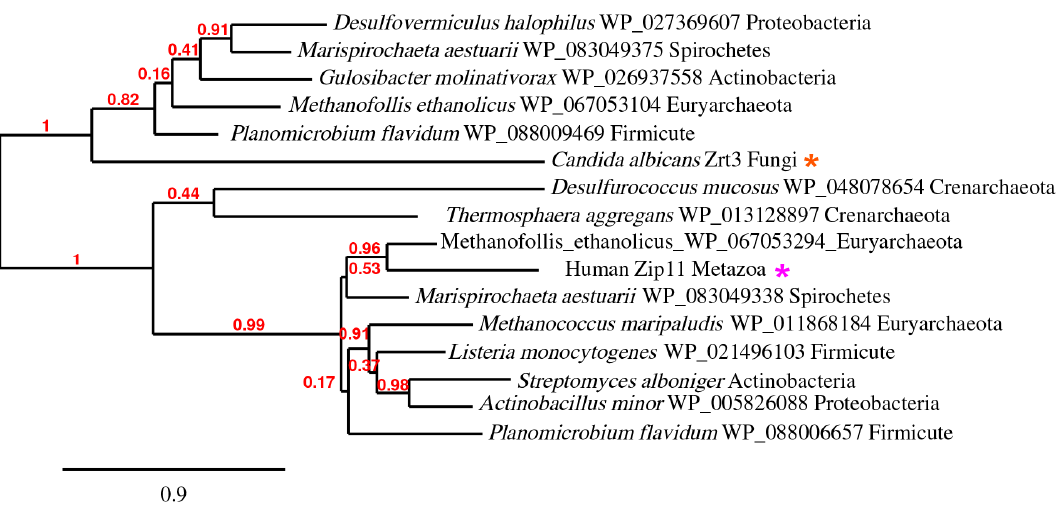
Figure 4. Pan-domain supercluster phylogeny. Phylogenetic tree generated using Phylogeny.fr (Available online: http://www.phylogeny.fr/). Note the presence of two branches with prokaryotic ZIPs related to both Fungal Zrt3 and Metazoan Zip11.